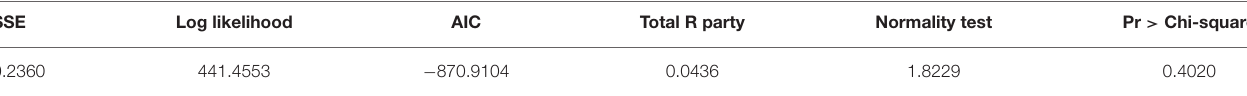
TABLE 10 | Parameter estimation results of model (11)